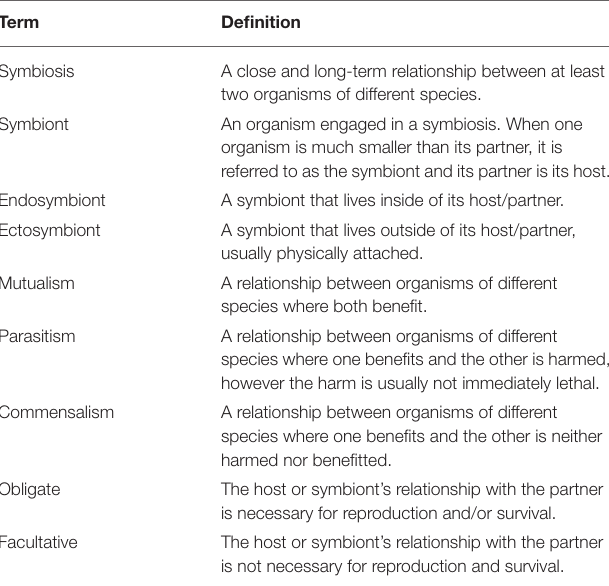
TABLE 1 | A list of definitions for terms used